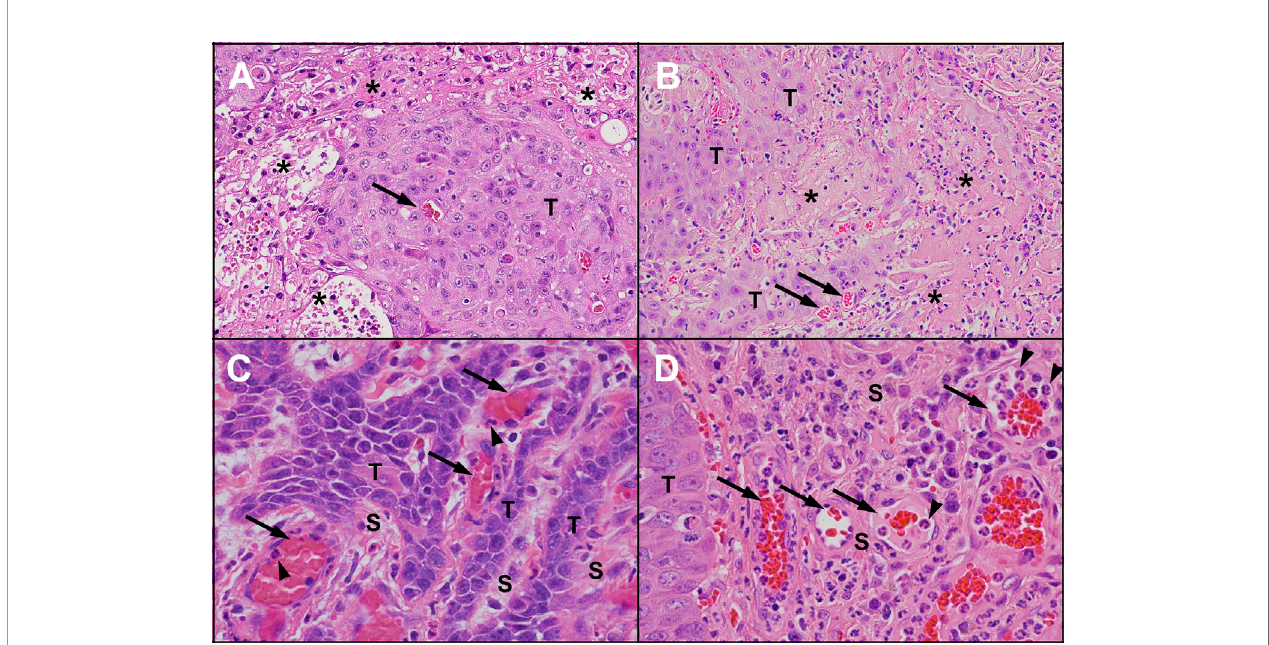
FIGURE 3 | Areas of necrosis and new blood vessel formation in untreated human and feline OSCC. Human (A) and feline (B) OSCC tumours showing transition from intact, viable-appearing OSCC tumour cells (T) to areas of necrosis (*) characterised by loss of structure and replacement with eosinophilic (pink) proteinaceous material and cellular debris. Small blood vessels are present near the tumour cells (arrows). One of the causes of tumour necrosis is hypoxia. Within the stroma (S) of human (C) and feline (D) OSCC, numerous blood vessels are present (arrows), indicating growth of new blood vessels into the region. In both (C, D) , in fl ammatory cells (neutrophils, arrowheads) are marginating along the endothelial surface. [haematoxylin and eosin stain, 20X objective (A, B) and 40X objective (C, D)